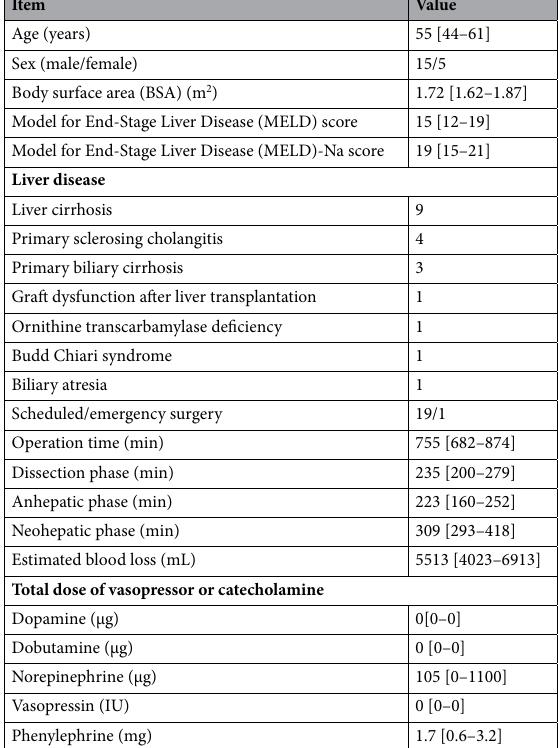
Table 1. Patient characteristics ( n = 20). Data are expressed as a number or median [25th-75th percentile].